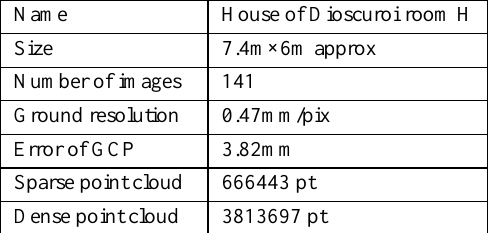
Fig.11 Orthographic images of the chromatic mosaic created from SFM & point cloud Table.4 Detail information of SFM: